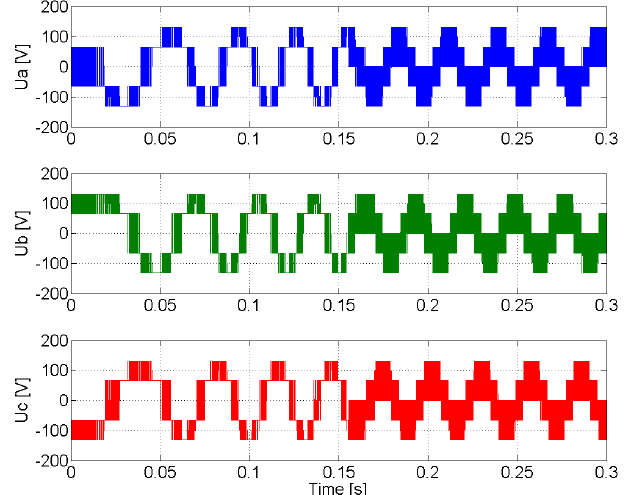
Fig. 12. Phase voltages of the motor with inverter operation in the Simulink model.